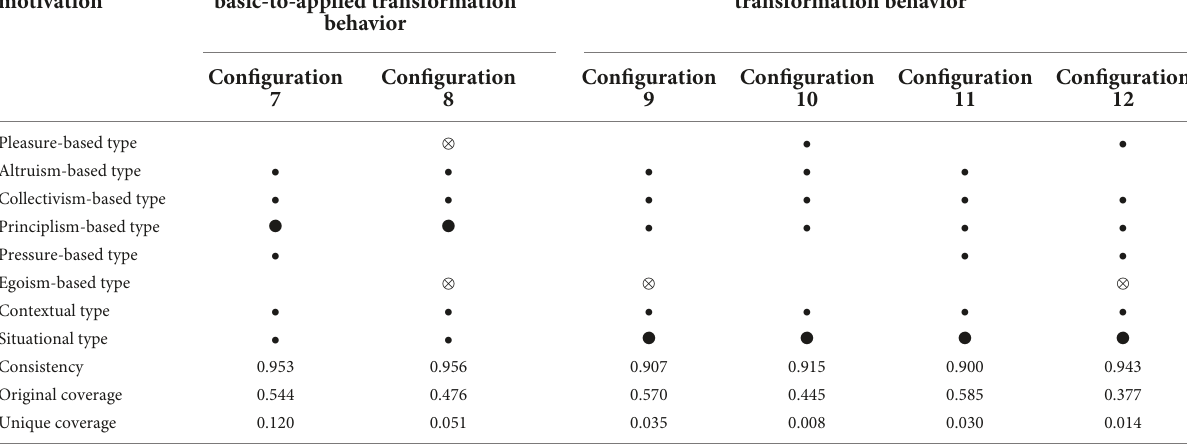
TABLE 6 Configuration solutions for high transformation behaviors between basic research and applied